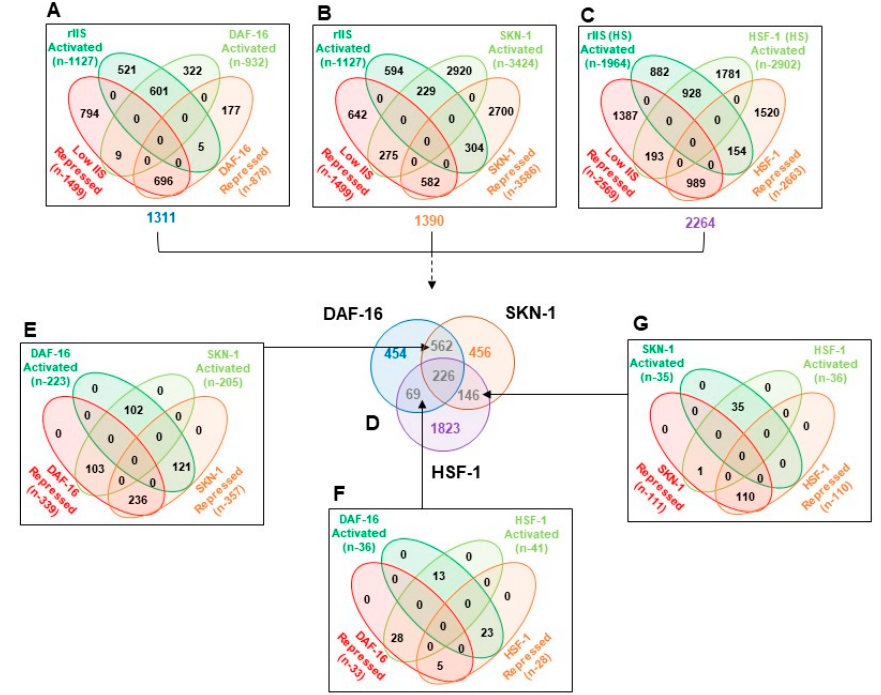
Figure A6. Identification of common genes. ( A – C ) Common genes between TFs and rIIS signaling were identified in all possible combinations. DAF-16 regulates a total of 1311, SKN-1-1390, and HSF-1 1831 under reduced IIS conditions. ( D ) Triple Venn diagram shows overlap among TF-regulated genes under rIIS condition. ( E – G ) Common activated and repressed genes by any two TFs under rIIS conditions were identified.